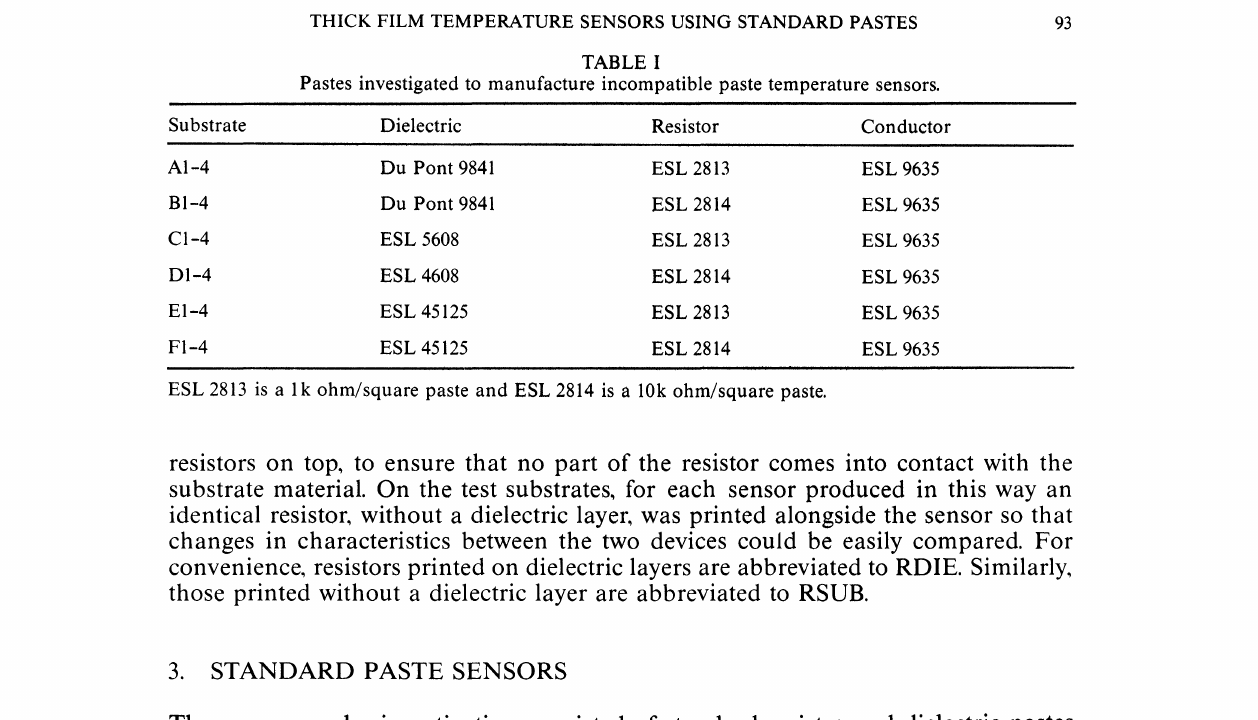
TABLE Pastes investigated to manufacture incompatible paste temperature